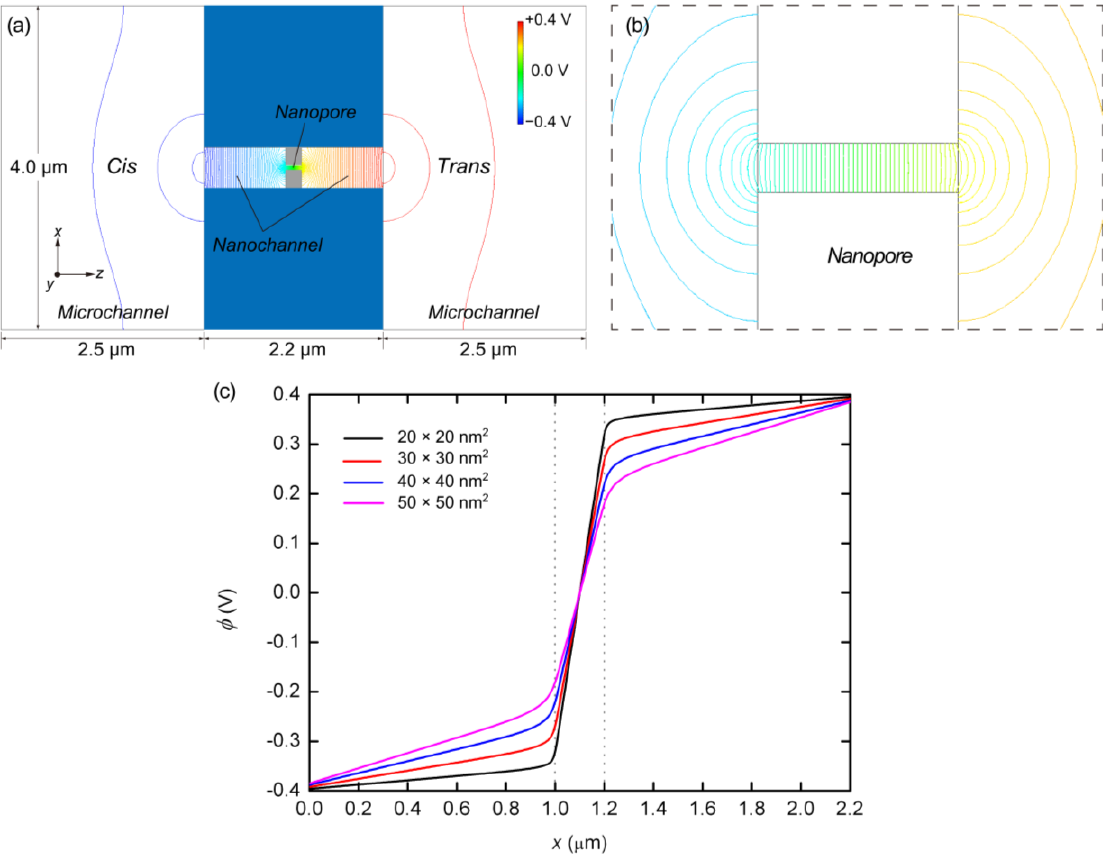
Figure 3. ( a ) Electrostatic potential resulting from FEM analysis for the system including microchannel, nanochannel, and nanopore whose cross-section is 50 × 50 nm 2 ; ( b ) Magnified view of ( a ) focusing on near the nanopore; and ( c ) Electrostatic potentials, ϕ, for nanopores of cross-section 20 × 20, 30 × 30, 40 × 40, and 50 × 50 nm 2 , resulting from three-dimensional FEM analyses. The entrance and exit of the nanopores are indicated by the dotted